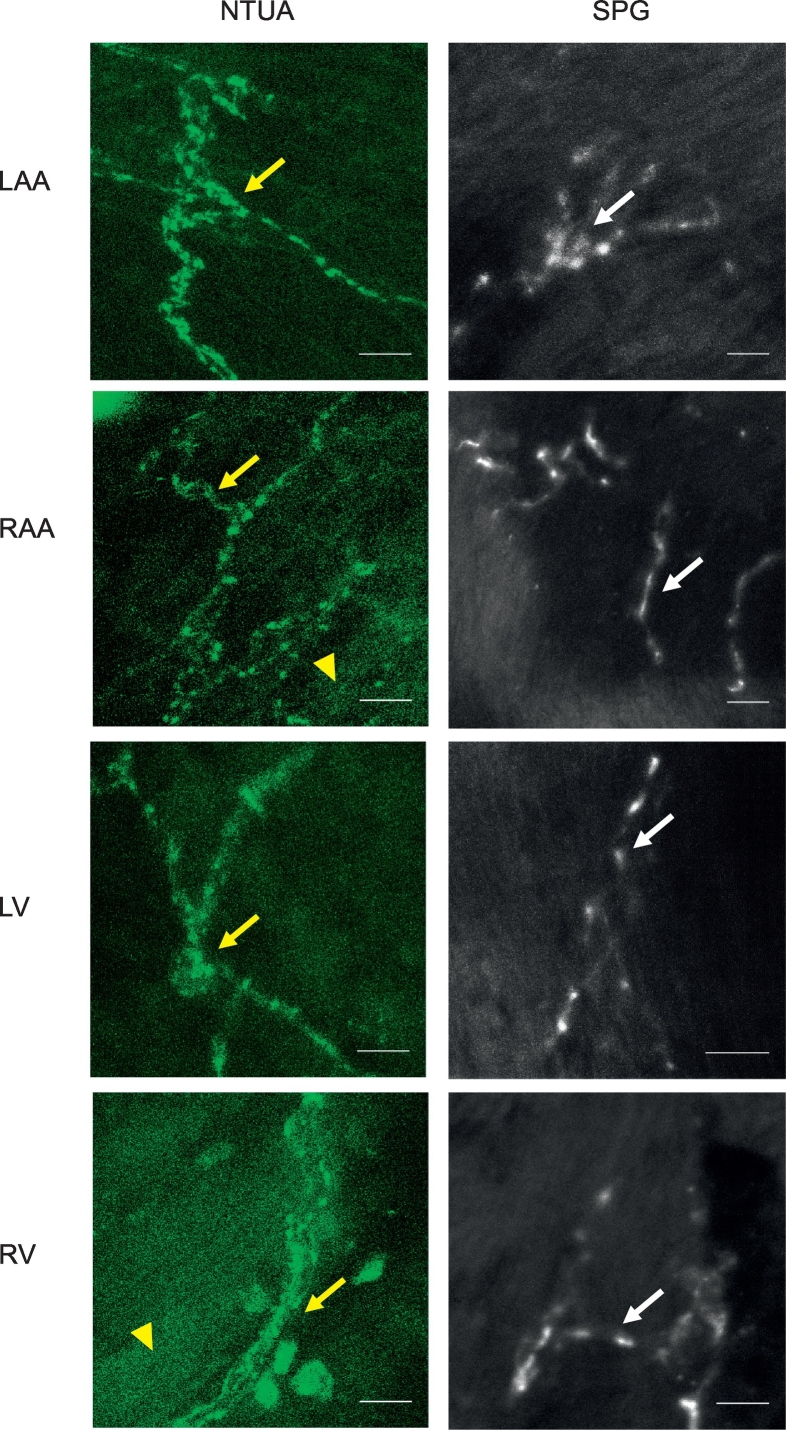
NTUA and SPG labelling of noradrenergic nerves in the mouse heart. NTUA labelling (left panels) and glyoxylic acid-induced histofluorescence (SPG; right panels) of each chamber of the mouse heart, i.e. left atrial appendage (LAA), right atrial appendage (RAA), left ventricle (LV) and right ventricle (RV). NTUA labelling and SPG histofluorescence yielded visualisation of noradrenegic neurones with single fibre axons. Yellow arrow heads mark the presence of non-neuronal fluorescence in response to NTUA treatment.For all micrographs, bars = 10 μm.